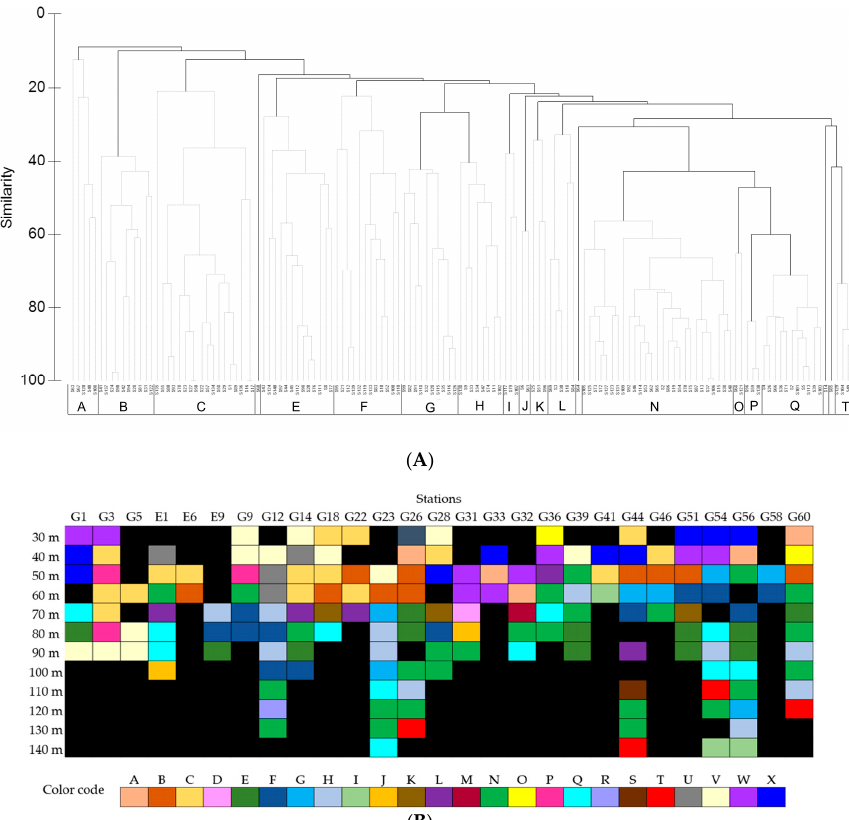
Figure 4. ( A ) SIMPROF analysis from the benthic composition in San Andrés. Significant clusters ( p < 0.01) used are illustrated in black, while groups that do not differ significantly are in grey. The black boxes and the letters A–T highlight the groups formed with significant differences that were used in the SIMPER analysis. ( B ) Color matrix with a different color for each of the 20 clusters (from A–T). The four other groups (U–X) represent the categories with 100% similarity (sand, coral pavement, scattered corals, and patch reef).